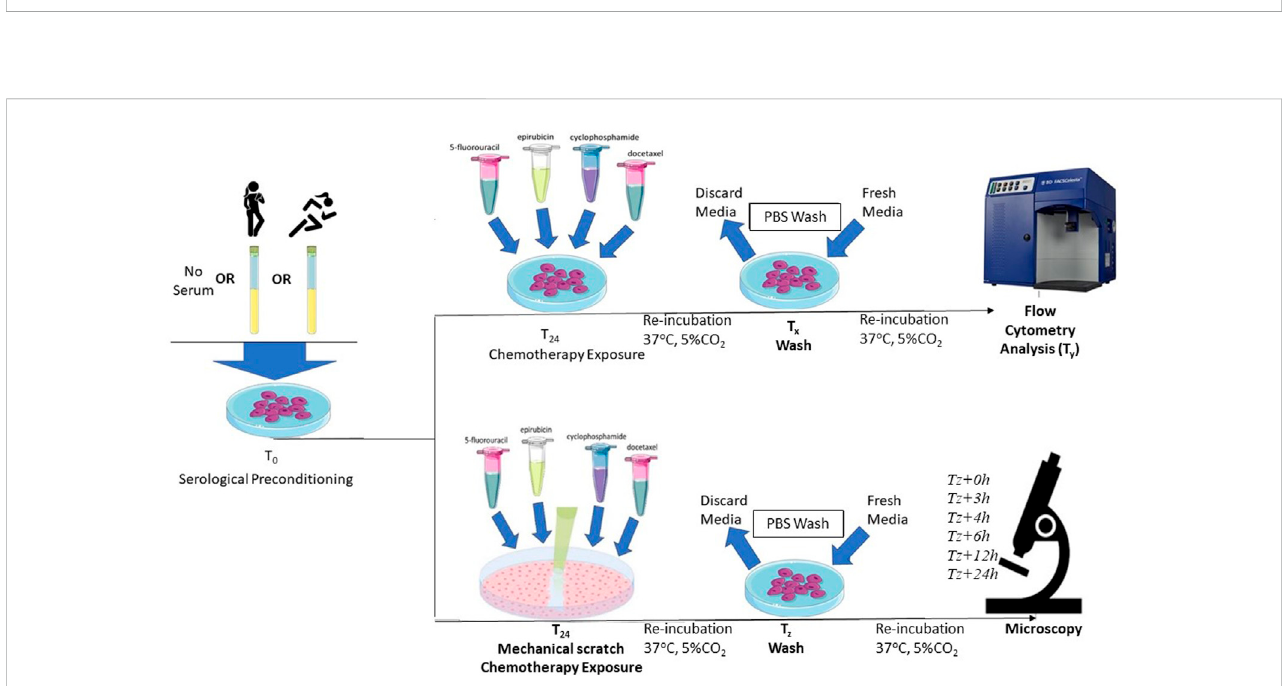
FIGURE 2 Schematic representation of the protocol for serum preconditioning of HCAECs at 0-h. For fl ow cytometry analysis, FEC-T chemotherapy exposure occurred 24-h after serum preconditioning. HCAECs were re-incubated and washed with PBS and fresh media added at corresponding time points (T x ), respective to each individual drug condition. HCAECs were then analysed by fl ow cytometry at corresponding time points (T y ), respective to each individual drug condition.For thewound healing assay,FEC-T drugs wereadded immediately after the monolayer was scratched.HCAECswere re-incubated and washed at corresponding time points (T z ), respective to each individual drug condition. HCAECs were imaged using Primovert Axiocam ERc5s microscope (ZEISS, Germany) using ×4 magni fi cation at 0-, 3-, 4-, 6-, 12-, 24-, and